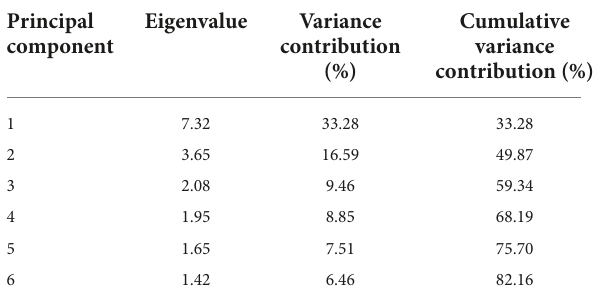
TABLE 5 Eigenvalue, variance and cumulative variance contribution of principal component